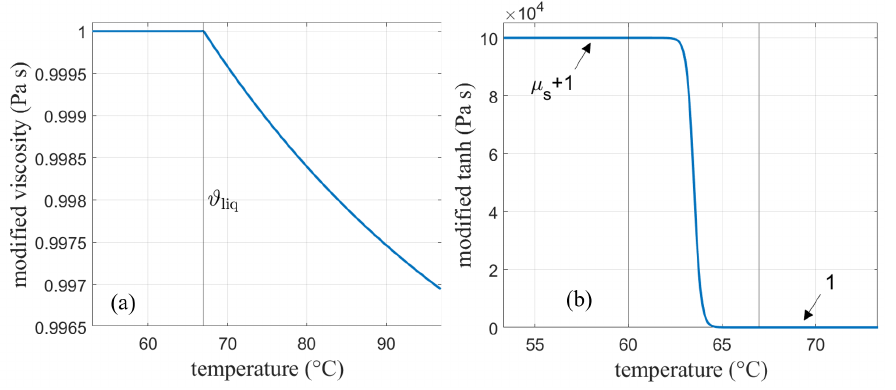
Figure 4. ( a ) Modified viscosity according to Equation (23) and ( b ) hyperbolic tangent according to Equation (24) function for calculation of overall